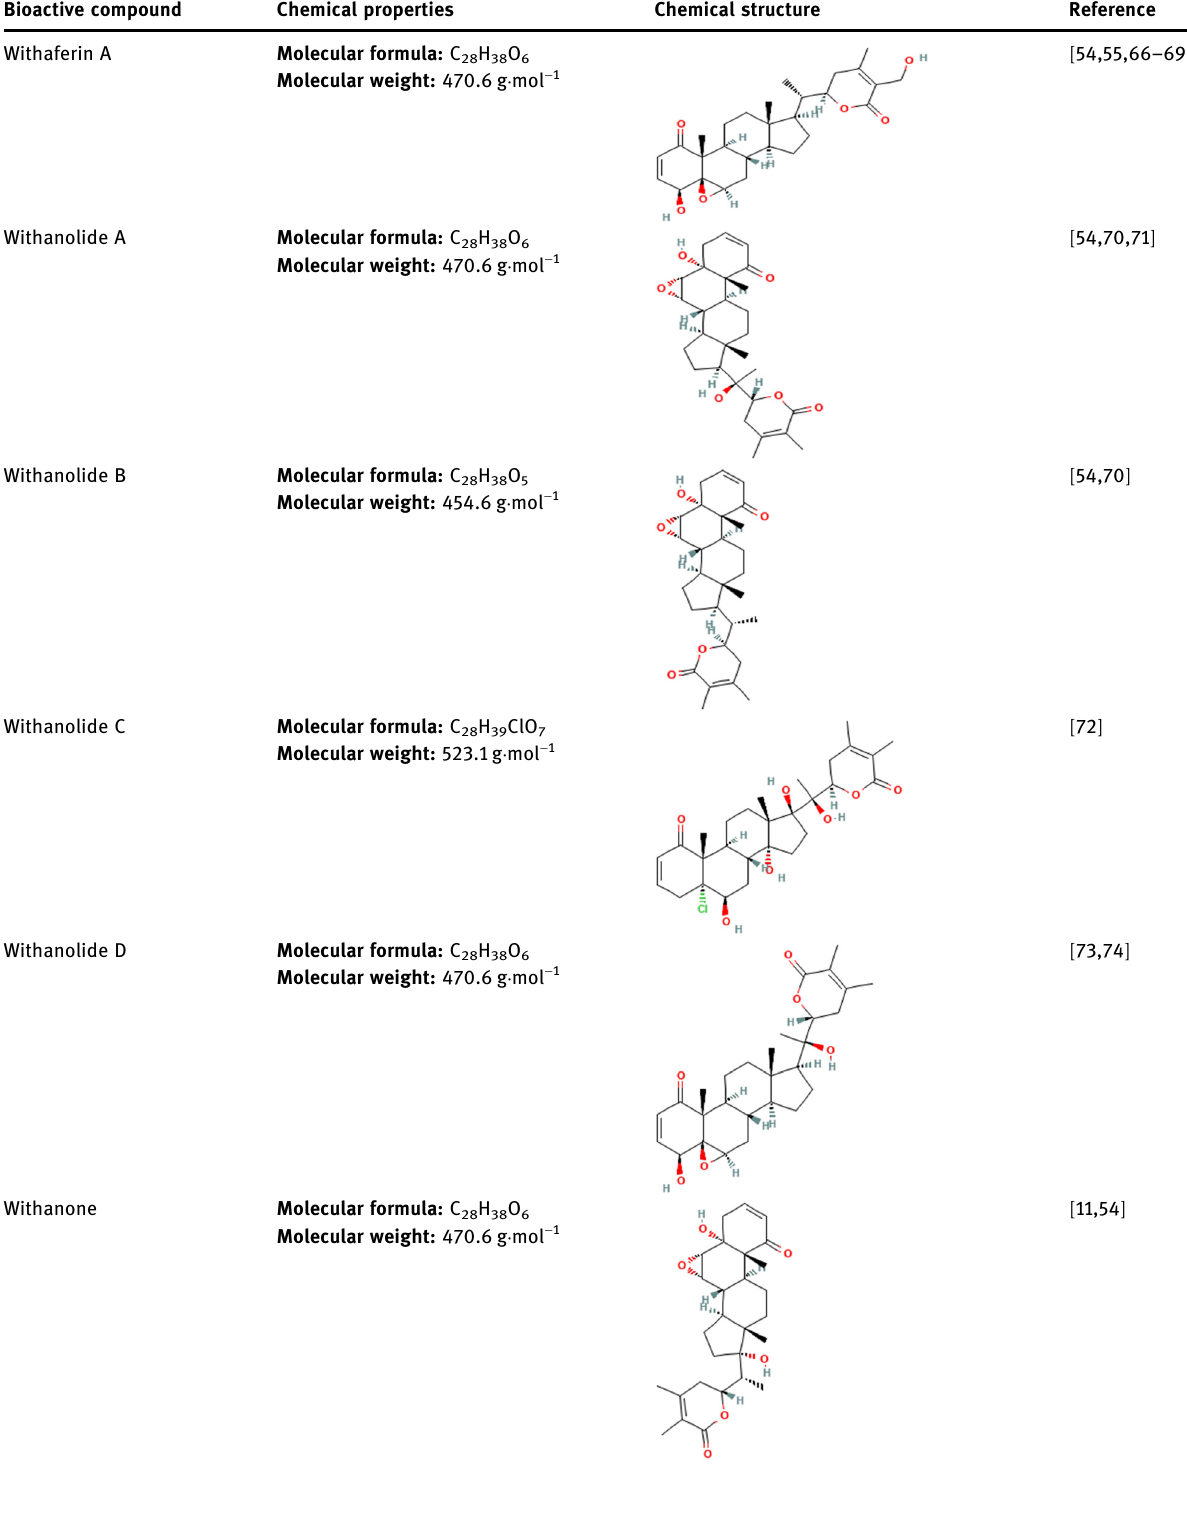
Table 1: Summary of the major bioactive compounds in the plant extract Bioactive